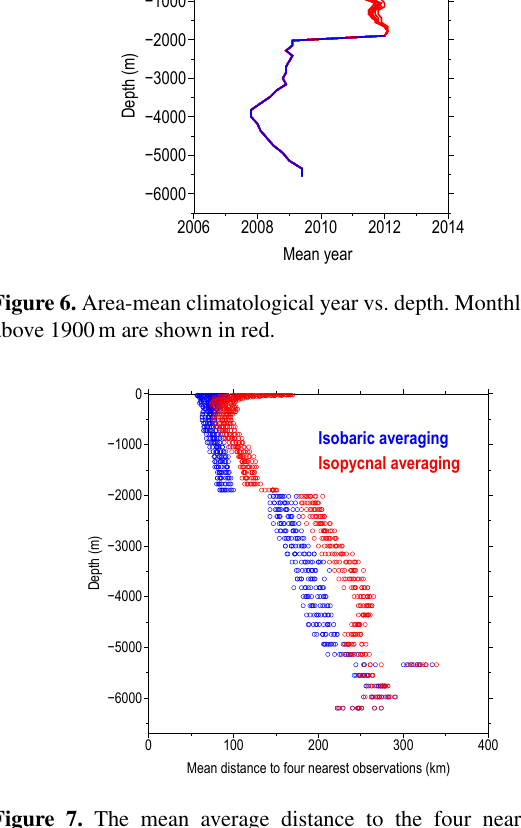
Figure 7. The mean average distance to the four nearest bin- averaged profiles vs.